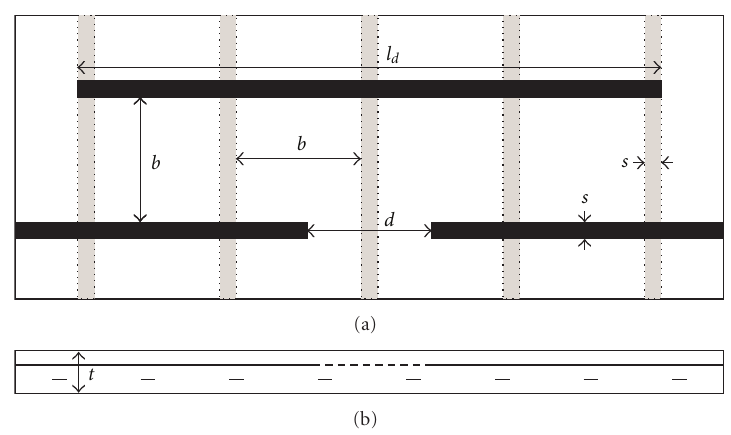
Figure 2: The design of the combined triangular lattice gangbuster together with the polarizer. The chosen values of the dimensions are given in the caption of Figure 3. The darker regions are metal, and the white region is dielectric. Each of the three dielectric spacers visible in (b) is t/ 3 thick. (a) Top view of the ( d + l d ) × (2 b + 2 s ) unit cell. (b) The cross-section of the FSS unit cell.